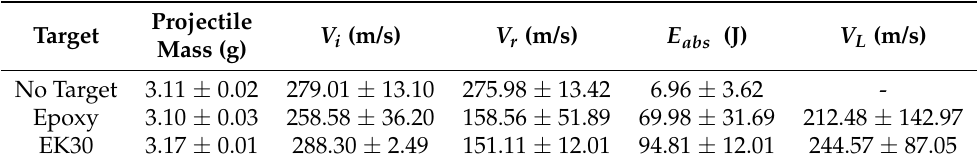
Table 3. Ballistic results of ten shots using 0.22 projectile against plain epoxy (EPOXY) and 30 vol% kenaf fiber (EK30) composite.